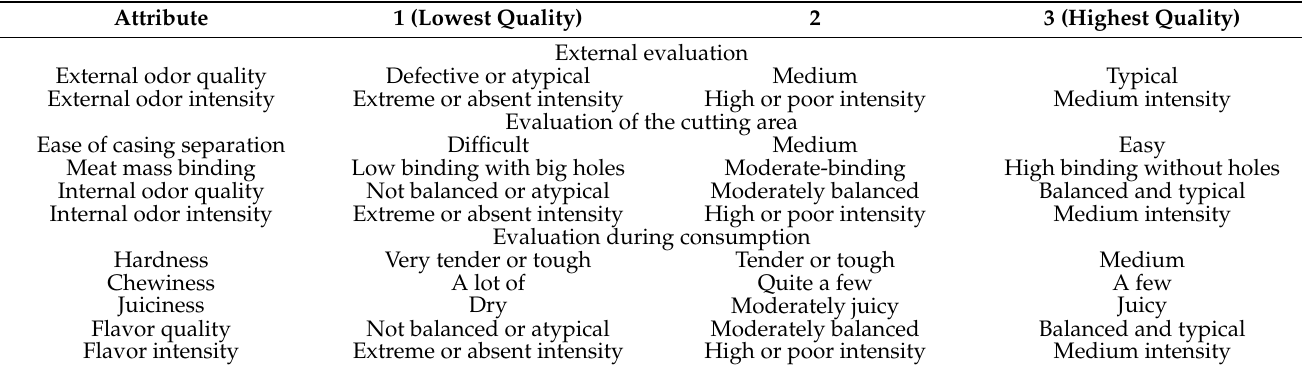
Table 3. Recodification of the sensory card used in the “Chorizo Zamorano” quality label. Attribute